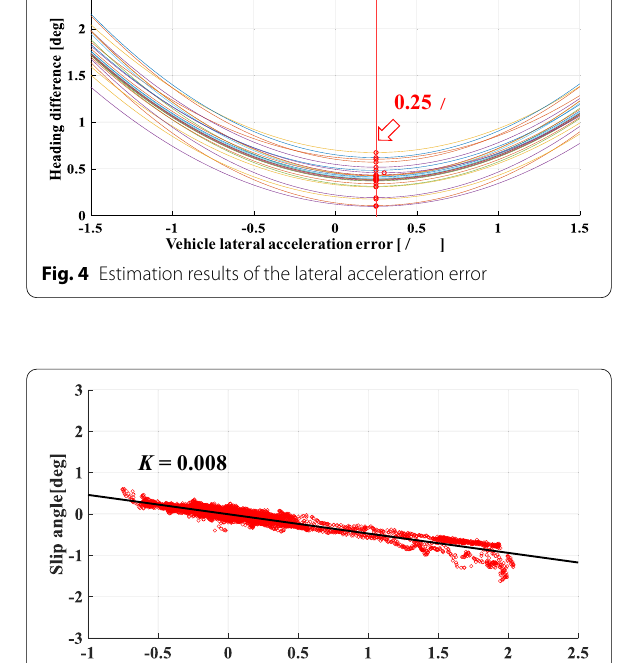
Fig. 5 Correlation between slip angle and lateral acceleration (POSLV220)